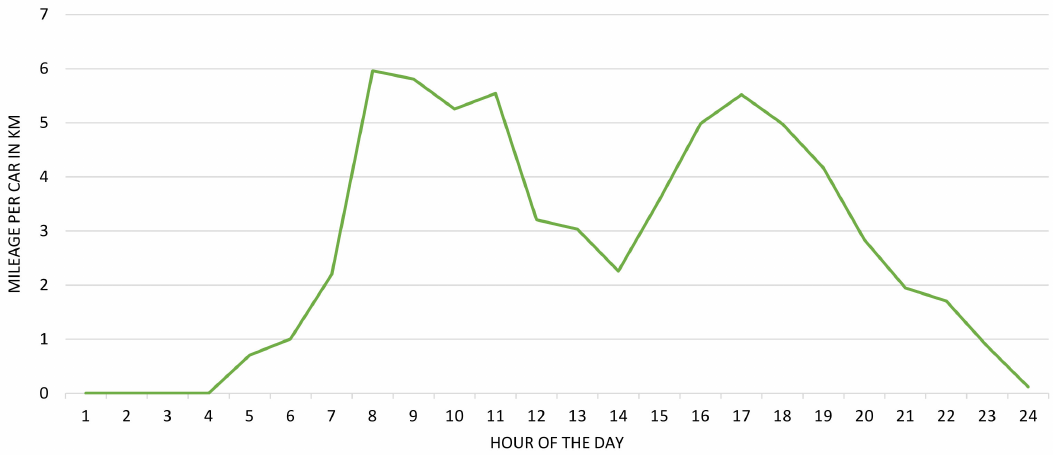
Figure 3. Mobility profile for a Monday in spring, normalized by all BEVs .